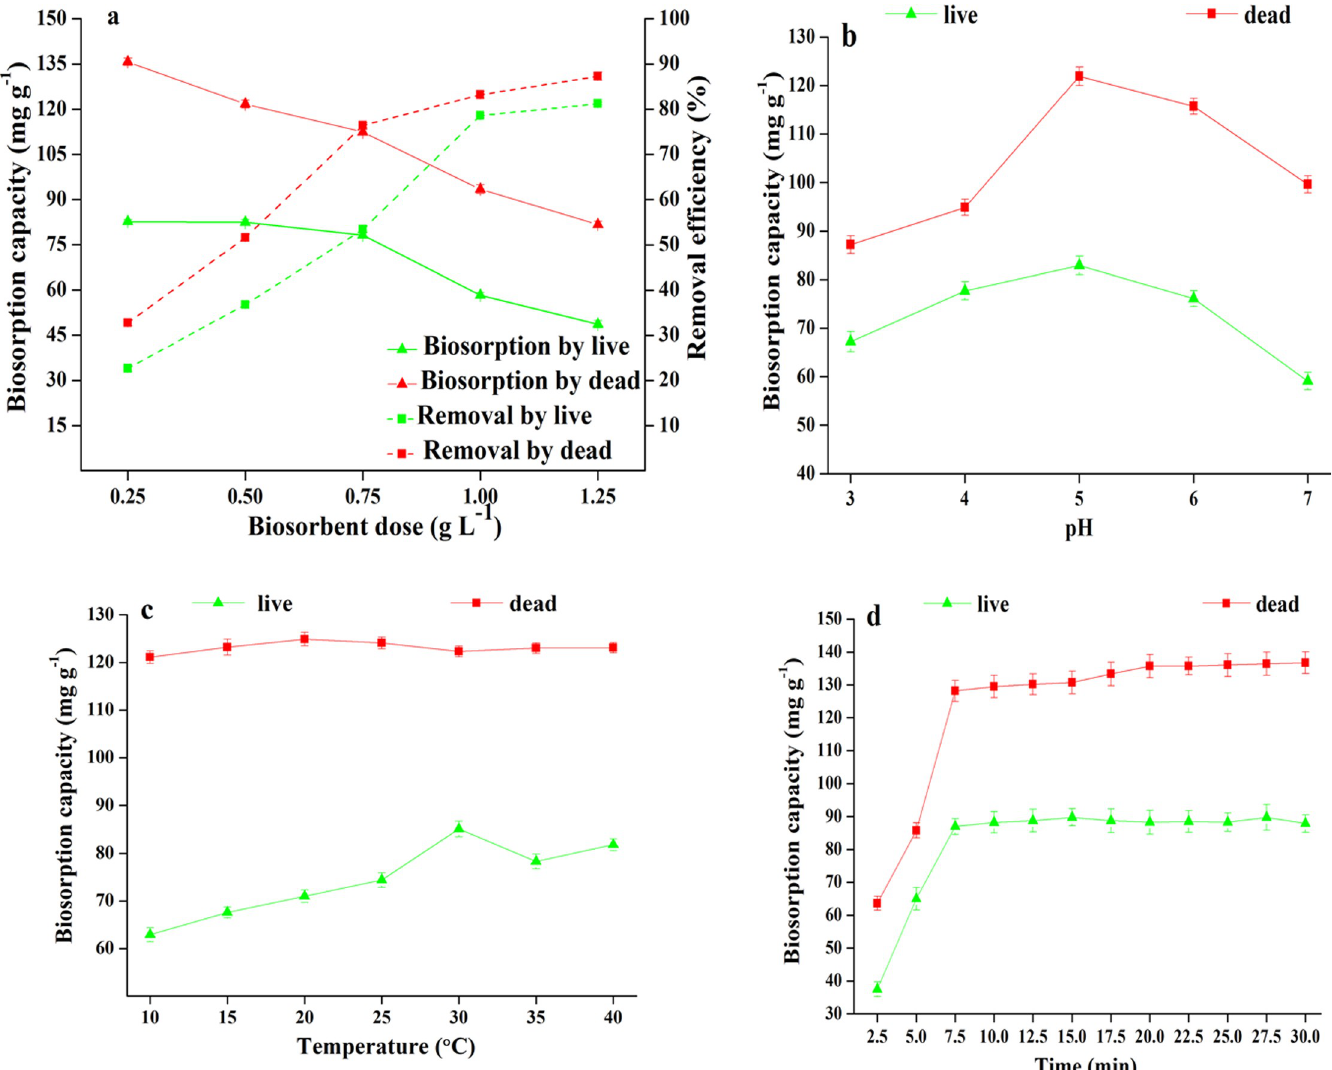
Fig 2. (a) Effect of biosorbent dose on biosorption capacity and removal efficiency of Pb 2+ by live and dead biosorbents. (initial Pb 2+ concentration: 200 mg L -1 ; temperature: 25˚C; pH: 5.0; agitation speed: 200 rpm min -1 ; contact time: 30min); (b)Effect of pH on biosorption of Pb 2+ by live and dead biosorbents(initial Pb 2+ concentration: 200 mg L -1 ; temperature: 25˚C; agitation speed: 200 rpm min -1 ; biosorbent dose: 0.75 g L -1 ; contact time: 30min); (c)Effect of temperatureon biosorption of Pb 2+ by live and dead biosorbents(initial Pb 2+ concentration: 200 g L -1 ; temperature: 25˚C; agitation speed: 200rpm min -1 ; biosorbent dose: 0.75 g L -1 ; contact time: 30min, pH = 5) (d)Effect of contact time on biosorption of Pb 2+ by live and dead biosorbents (initial Pb 2+ concentration: 200 g L -1 ; temperature: 20˚C for dead biosorbents and 30˚C for live biosorbents; agitation speed: 200rpm min -1 ; biosorbent dose: 0.75 g L -1 ; pH =